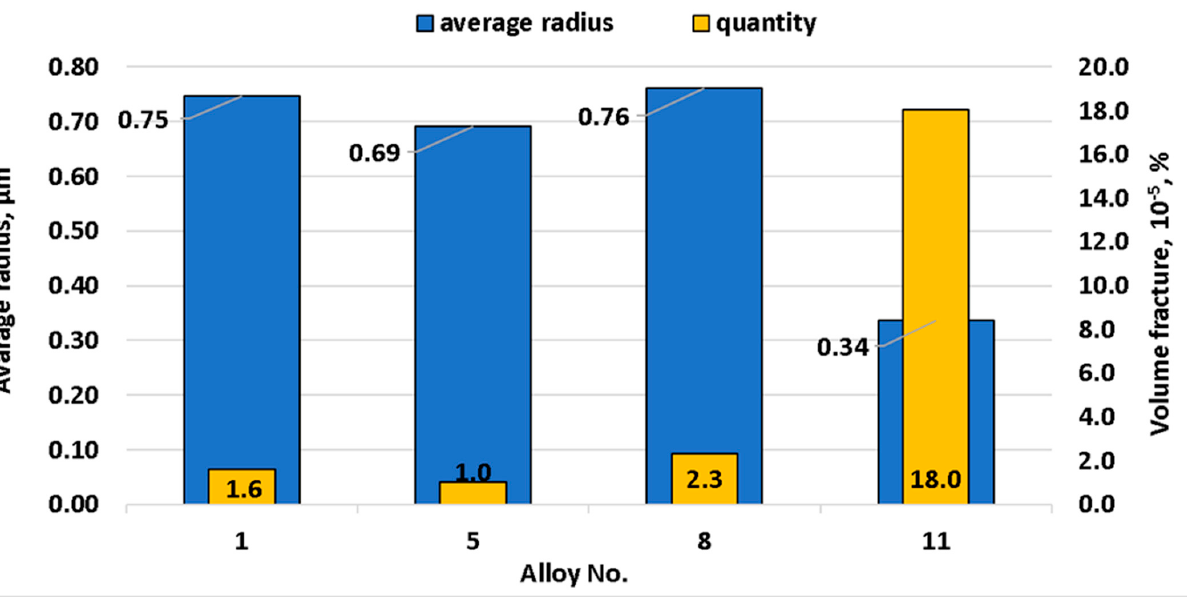
Figure 6. Changes in intermetallic compound size and number related to alloy chemical composi- tion.